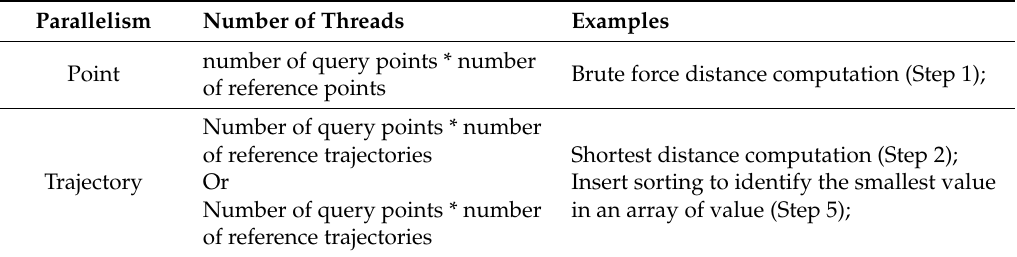
Table 2. Two types of parallelism: point and